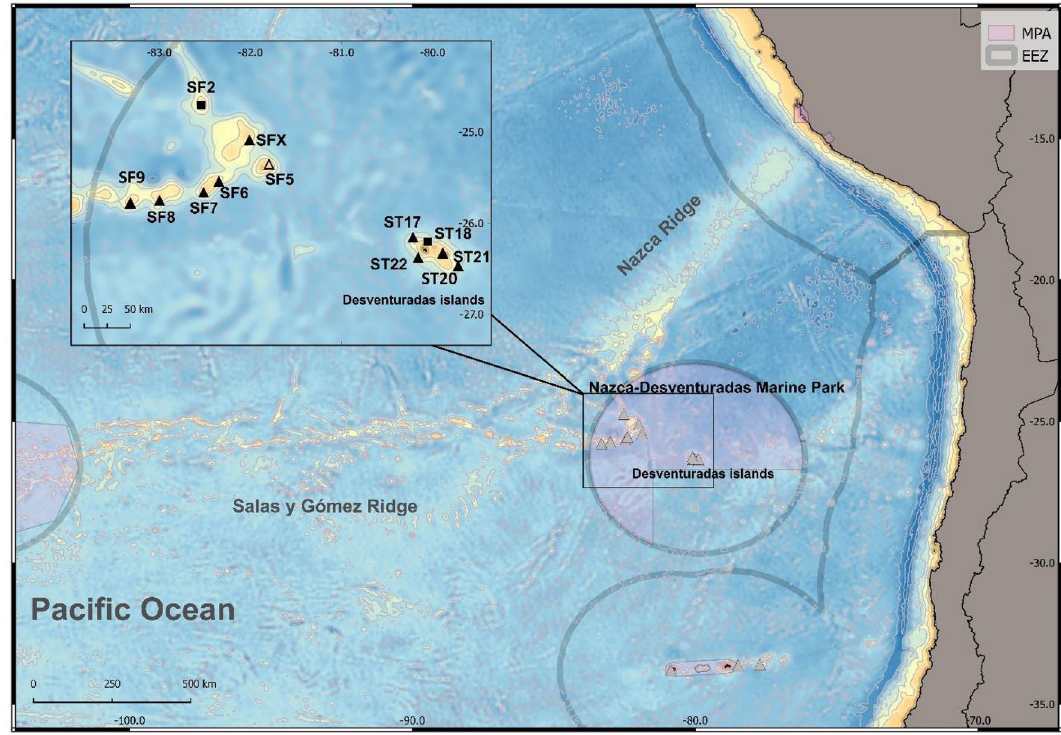
Figure 1. Location of the benthic stations sampled during CIMAR 22 cruise (13 October to 14 November 2016). Locations with Agassiz trawls and ROV deployments (filled upward triangle), only ROV deployments (filled square), and only Agassiz trawls (white upward triangle). Map generated using QGIS (version 3.10) 72 Data collection. From 22 October to 1 November 2016, benthic surveys were performed at five stations on the upper slope of the Desventuradas Islands and the summits of seven nearby seamounts of the NR (Fig. 1). A Commander MK2 (Mariscope Meerestechnik, Kiel, Germany) ROV equipped with an HD Camcorder (Pana- sonic SD 909, resolution 1920 × 1080, 30 fps), a GoPro Hero camera (resolution 2704 × 1520, 60 fps) and laser pointers (10 cm apart) was used to survey benthic habitats and communities. A total of 11 ROV dives were con- ducted at ~ 40 to 370 m depth (Table S1); five on the slope of Desventuradas Islands (5 h of total bottom time) and six on the seamounts (6 h of total bottom time). The ROV observations were descriptive and did not aim to obtain quantitative data due to the potential overlapping of the paths of the surveys. Benthic trawling was performed at stations where either multibeam or ROV observations indicated suitable soft bottoms. Trawls were conducted for ~ 4 to 15 min (bottom contact) with a constant speed of ~ 3 knots at each station (Table S1). The gear used was a modified Agassiz trawl, with a mouth of 1.5 m × 0.5 m (width × height) fitted with a net of 12 mm mesh at the cod end. A total of 10 trawls were conducted; four on the slope of the Desventuradas Islands and six on the seamount summits, with sampling depths ranging from 133 to 340 m (Table S1). Both trawl and ROV deployments were possible at all stations, except at ST18 and SF2 (only ROV data because the bottom was too rocky to safely conduct trawls) and at SF5 (only trawl data because strong cur- rents prohibited ROV deployment) (Fig. 1). Environmental data (i.e., temperature, salinity and oxygen) used in our analysis were obtained from the global three-dimensional CSIRO Atlas of Regional Seas (CARS) climatology (2009 version) as presented by Mecho et al. 37 . Habitat description based on ROV videos. The oceanic islands (OI) and seamounts (SM) were consid- ered as two different environments (corroborated by statistical analyses presented below) and were referred to as subsystems, based on differences in physiography and depth. The characteristics of the seafloor habitats for each subsystem were described based on ROV data. Videos for each dive were analyzed in a time-lapse mode at half normal speed in VLC media Player 3.0.11 38 . Habitats were classified at different spatial scales: (1) macrohabitats